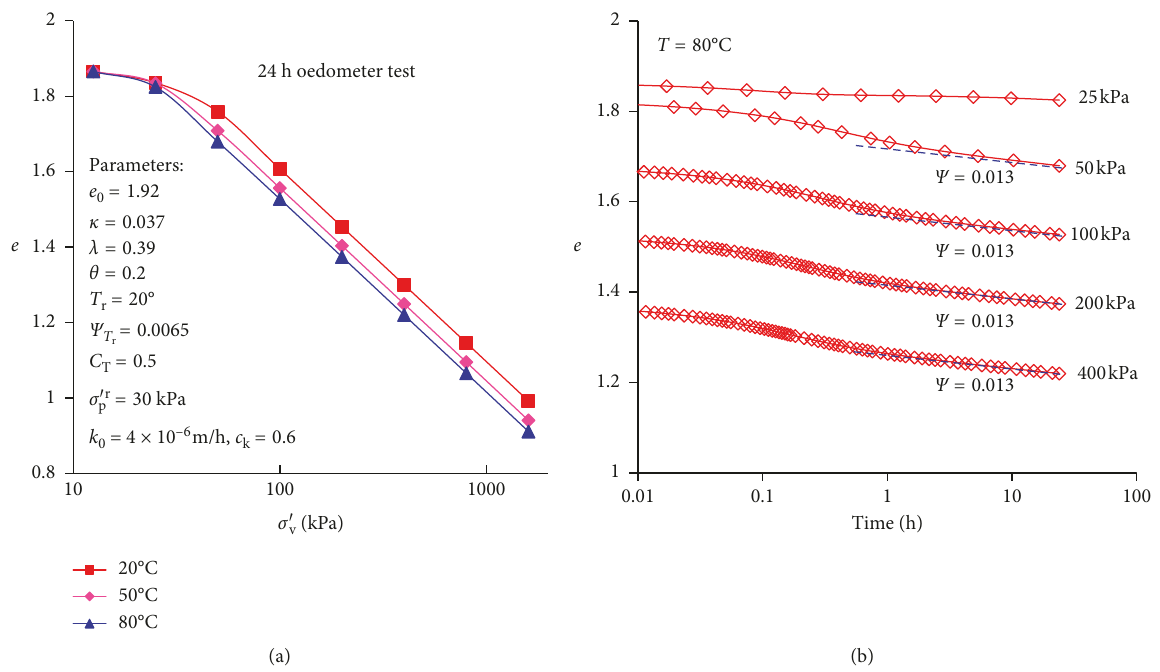
Figure 5: Simulations for 24 h oedometer tests: (a) compression curves at different temperatures; (b) compression behavior at each load increment for the test simulated at T 80 ° (cid:31)